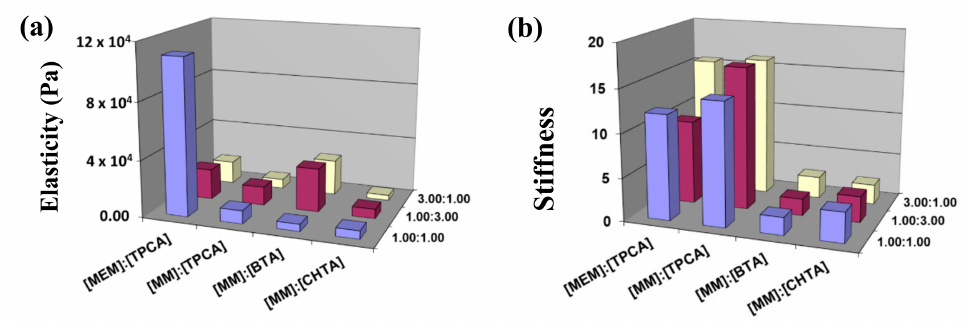
Figure 9. Bar diagram of values of ( a ) Elasticity and ( b ) Stiffness of the hydrogel networks of four systems at three different molar ratios.